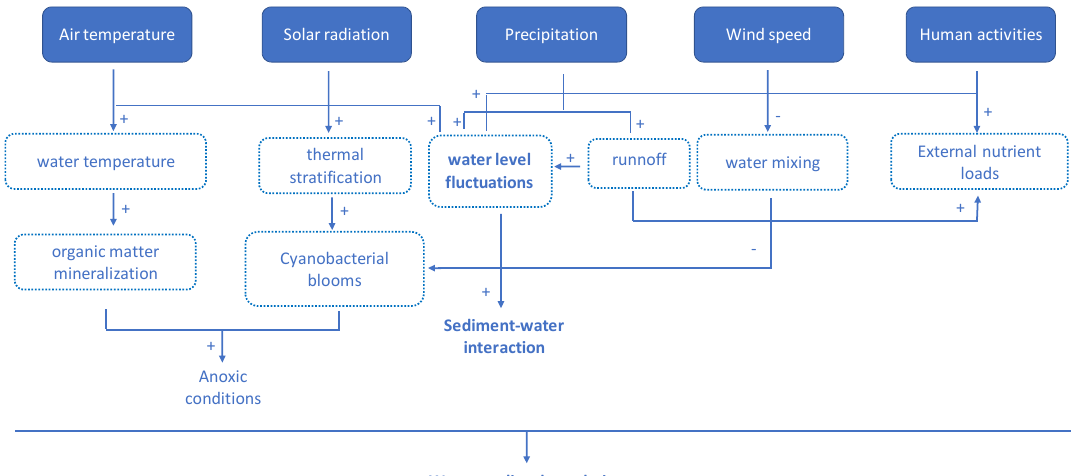
Figure 2. Major drivers of global change on Mediterranean wetlands (modified from [34]). The main issues addressed in this review are marked in bold